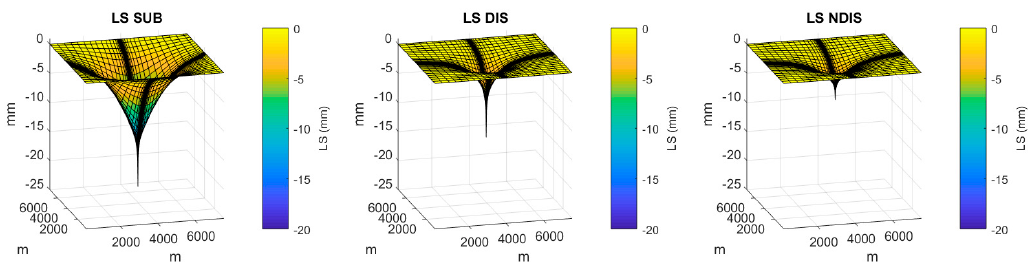
Figure 9. Subsidence calculated by SUB, DIS, and NIDS packages for the conceptual model.